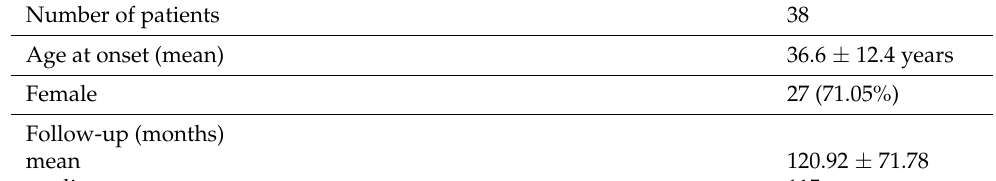
Table 1. Demographics and clinical features of 38 patients with Vogt–Koyanagi–Harada disease. Number of